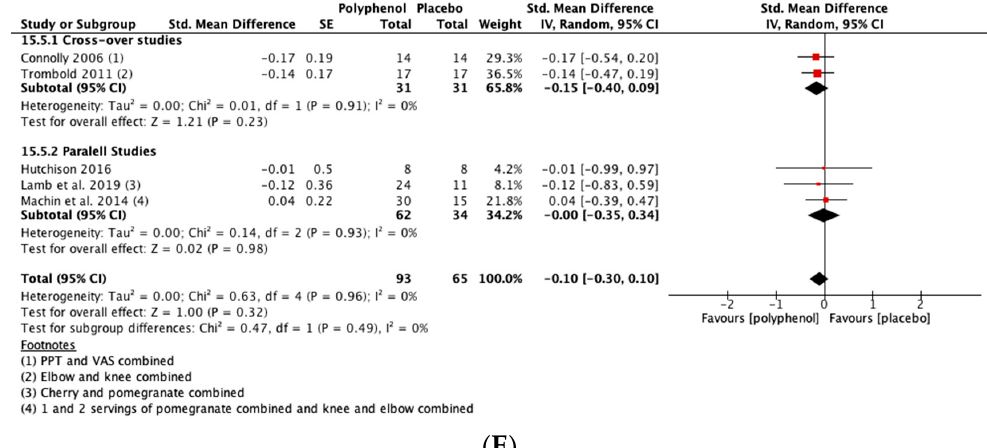
Figure 4. Effect of polyphenol-rich foods, juices and concentrates on recovery of delayed onset muscle soreness ( A ) immediately post-exercise; ( B ) 24 h; (C) 48 h; ( D ) 72 h; ( E ) 96 h. Unless stated otherwise SMDs are calculated from VAS of DOMS. PPT: Pain pressure threshold. VAS: Visual analogue scale.